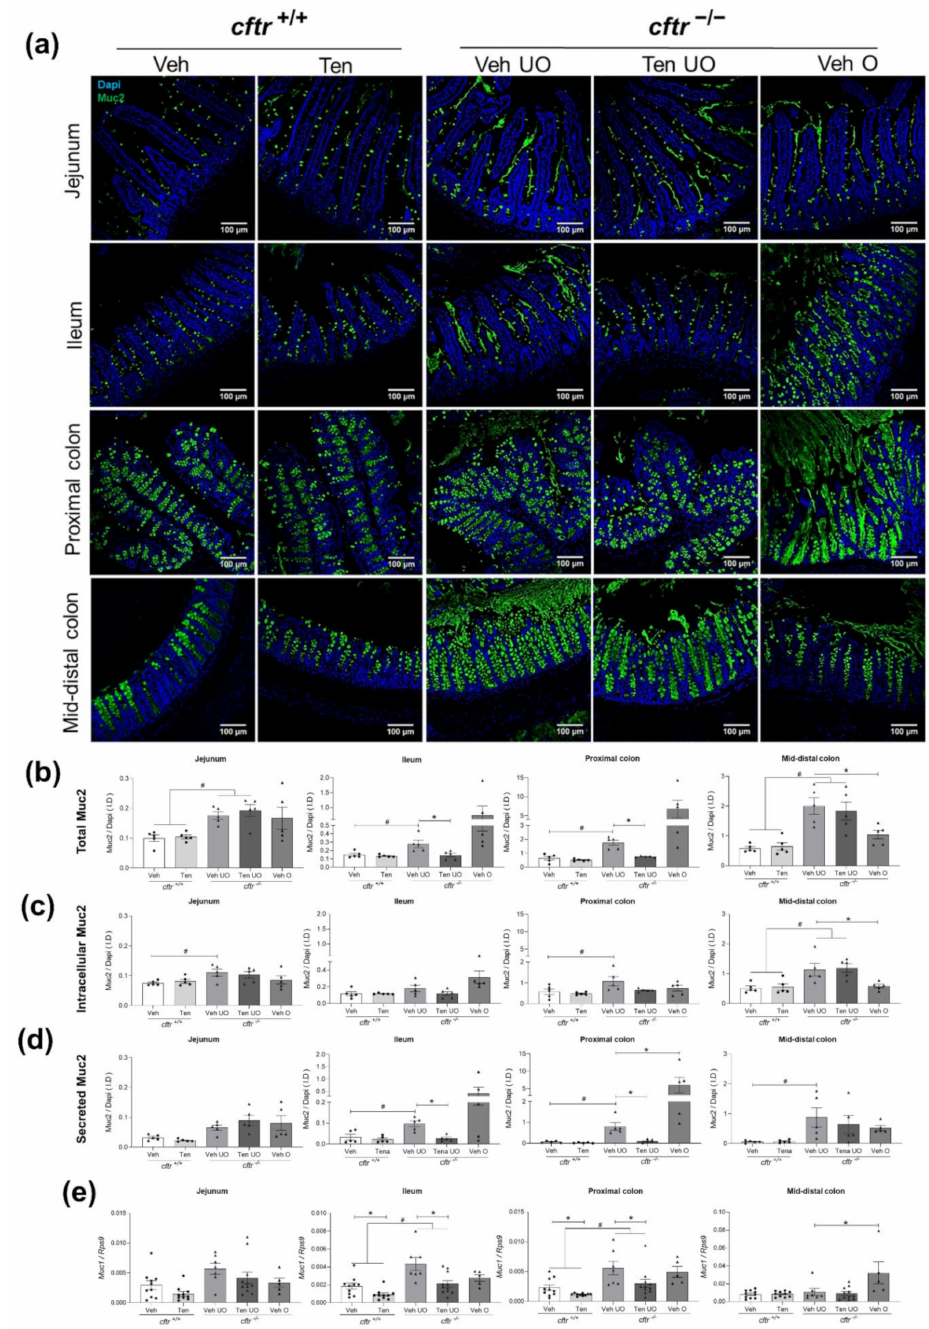
Figure 5. Decrease in mucus accumulation in tenapanor-treated cftr − / − mice. ( a ) Representative images of Muc2 immunohistochemistry (major component of the secreted colonic mucin) of jejunum, ileum, proximal colon, and mid-distal colon in cftr +/+ and cftr − / − mice treated with either vehicle or tenapanor (n = 5/genotype/group/intestinal segment). ( b ) Fluorescent intensity (I.D) ratio of Muc2 in relation to Dapi immunofluorescence ( c ) localized to the goblet cell thecae (intracellular mucus pool) and ( d ) localized to the luminal compartment (secreted mucus). ( e ) mRNA expression of Muc1 in these intestinal segments. Each dot/triangle represents one mouse. Veh—vehicle, Ten—tenapanor, UO—unobstructed, O—obstructed, I.D—Integrated density. Data are represented as means ± SEM. # is used to represent the statistical analysis performed between the two different genotypes and * is used to represent the statistical analysis performed between the vehicle and tenapanor groups or between unobstructed and obstructed vehicle groups. # and *, p <